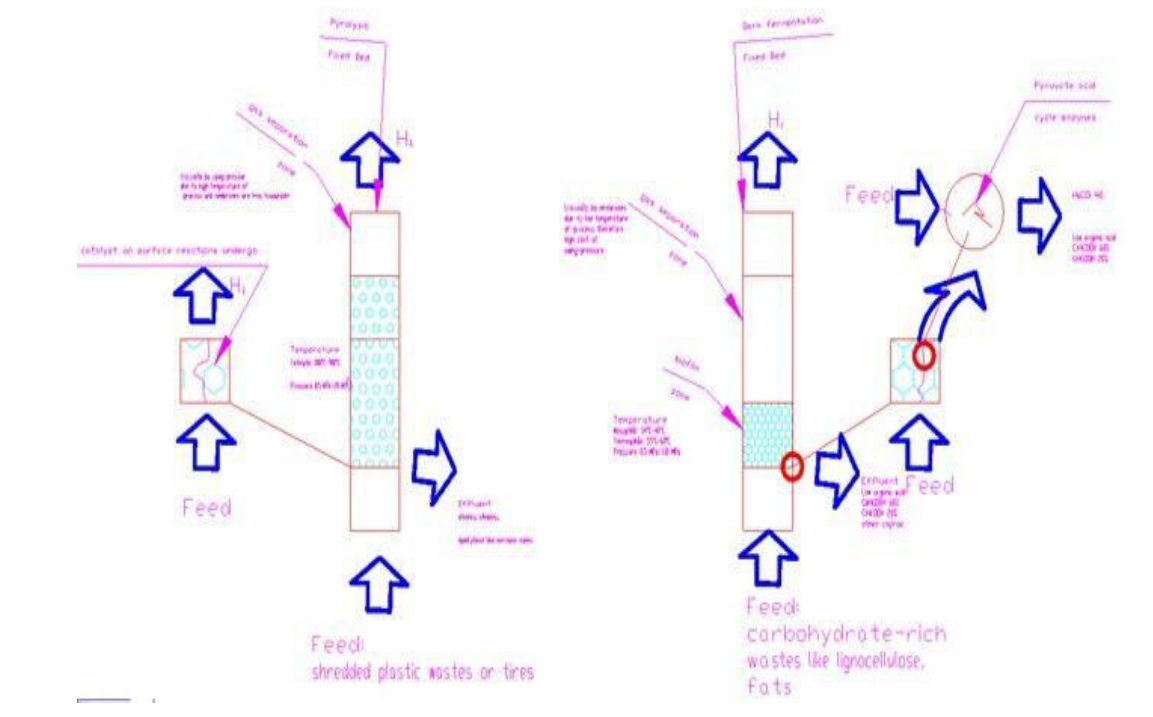
Figure 1. Comparison of fixed bed reactor for pyrolysis and dark fermentation. Reactor designs have different thresholds in bioprocesses and pyrolysis. In pyrolysis, projection requires a proper catalyst. In bioprocesses such as dark fermentation, the role